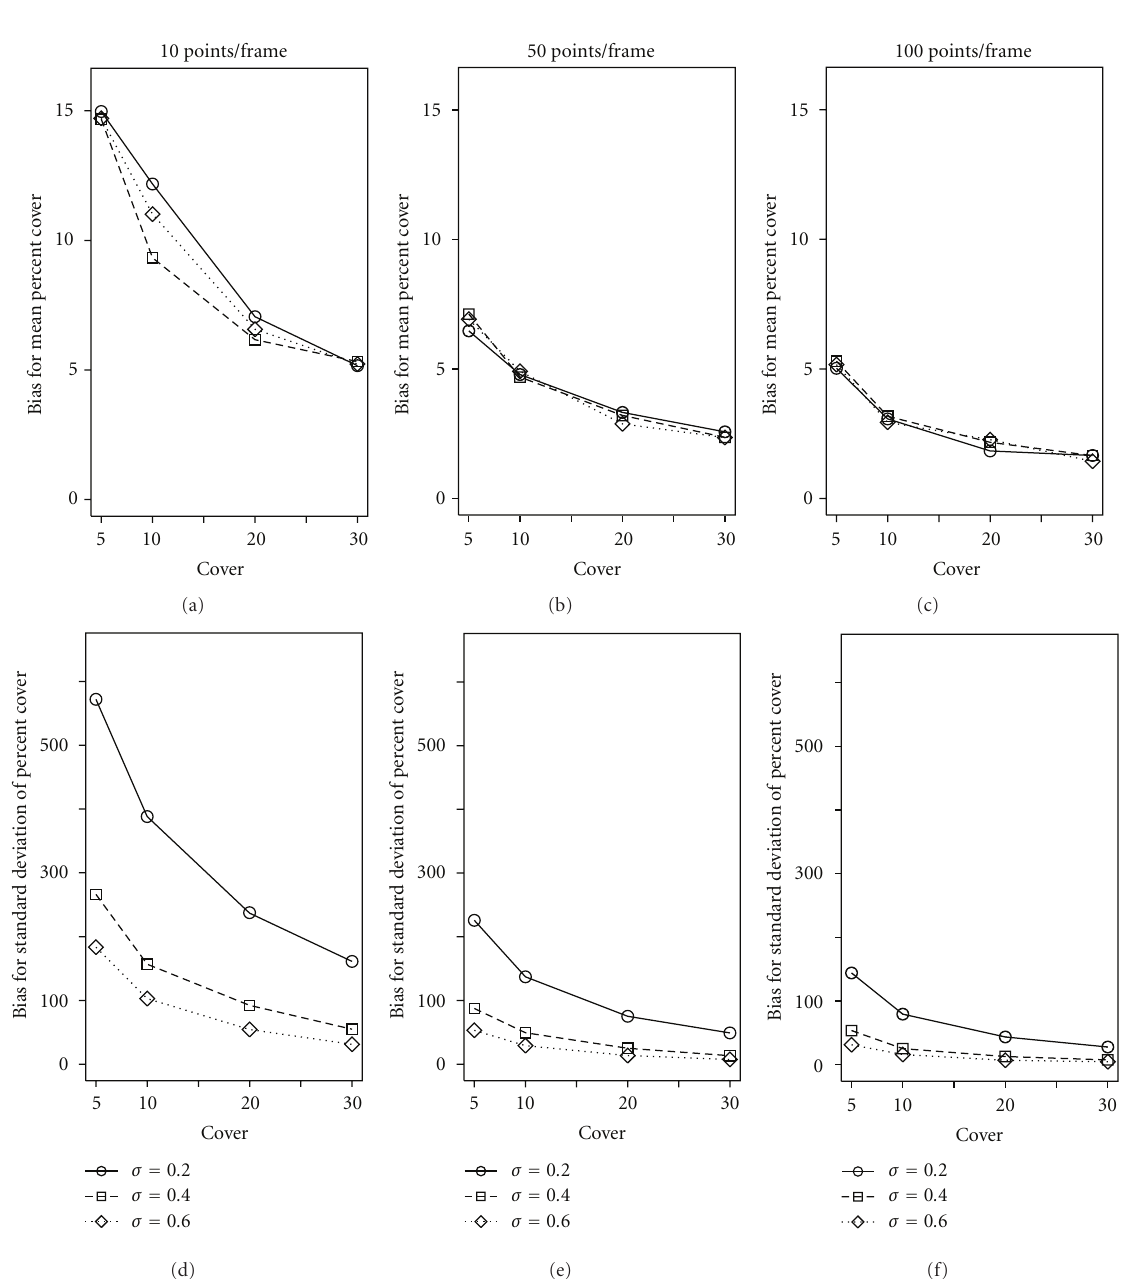
estimate to the true mean percent cover would lead to a “false alarm” (cover dropped by 4.8%) or type I error. If, on the other hand, this estimate was used as a baseline, and the same transect was to lose 5% cover over the years, a comparison would lead to a “false negative” or type II error (e.g., [26]). Investigators must therefore insure that measurement error remains below levels of biologically meaningful